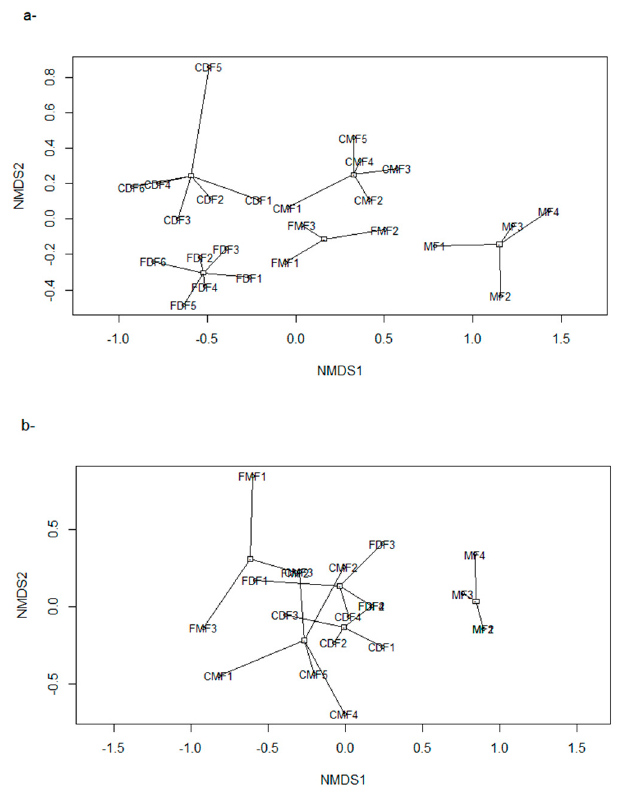
Figure 4. Non-metric multidimensional scaling ordinations of bird ( a ) and medium-large mammal ( b ) sampling units based on species abundance. Centroids of the sampling units belonging to continuous dry forests (CDF), fragmented dry forests (FDF), continuous moist forests (CMF), fragmented moist forests (FMF), and upper montane forests (MF) are represented by a square.